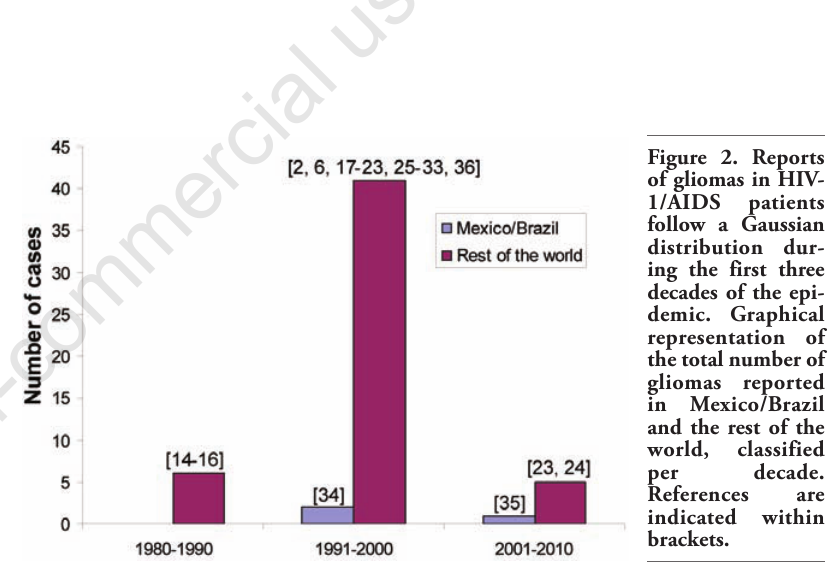
Figure 1. HAART has reduced the number of PCNSL cases in AIDS patients. Graphi cal representation of the prevalence of PCSNL in patients with HIV-1/AIDS during 3 decades. References are indicated within brackets.